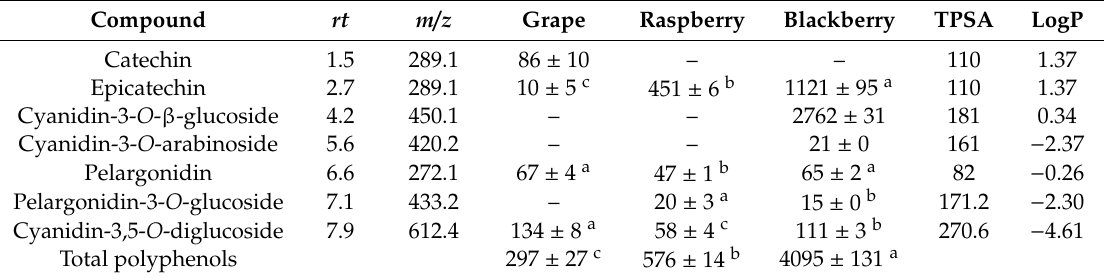
Table 1. HPLC-ESI-q-TOF-MS and cheminformatics of polyphenols from three edible berries 1,2 . Compound rt m /